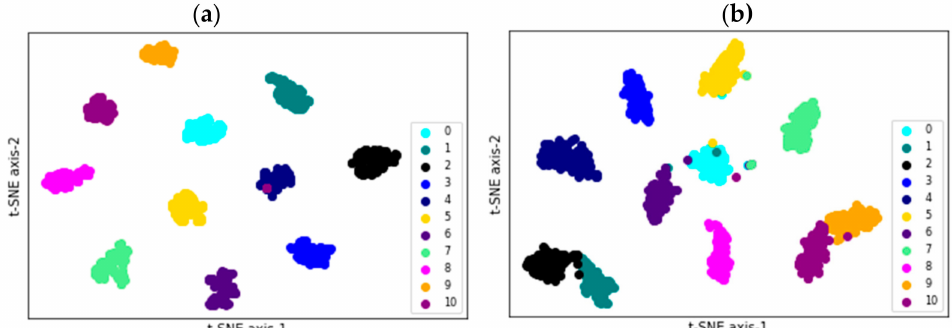
Figure 7. t-distributed stochastic neighbor embedding (t-SNE) visualization of untrained new datasets with measurement size (e.g., 120–150 s) and damage severity (intact and random damage quantity of 20–50%): ( a ) Random excitation and ( b ) traffic